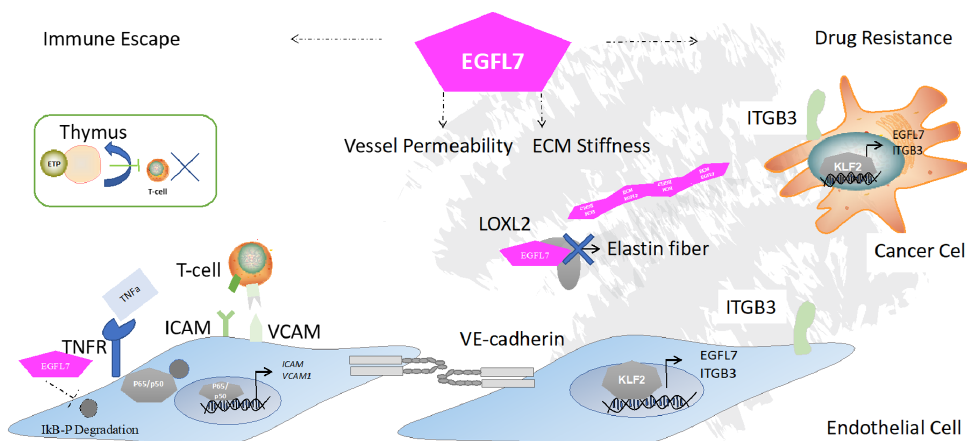
Figure 2. EGFL7 alters tumor growth and metastasis by suppressing the production of immune cells and their recruitment into the growing tumors, vessel permeability, ECM stiffness—all of which contribute to drug resistance. T cell adhesion and rolling and transmigration through the EC are required for T cells to cross the vascular barrier. EGFL7 allows the tumor to escape from the anti-tumor immune response by preventing terminal T cell differentiation in the thymus and inhibiting T cell recruitment via suppression of the adhesion molecules ICAM and VCAM on ECs. EGFL7 prevents adhesion molecule transcription after tumor necrosis factor alpha (TNFa) stimulation by blocking Nuclear factor kappa B (NFkB) signaling. EGFL7 controls ECM stiffness by interacting with LOXL2 so as to mitigate covalent crosslinking of collagen or elastin. ITGB1 integrin on ECs and ITGB3 integrin on cancer cells [45] induce the expression of transcription factor KLF2 which enhances EGFL7 expression, resulting in enhanced cell proliferation. Myelosuppressive drugs such as bortezomib were shown to enhance KLF2-mediated upregulation of ITGB3 and EGFL7. Abbreviations: KLF2, Krüppel-like factor 2; ETP, early thymic progenitor; LOXL2, lysyl oxidase-like 2.